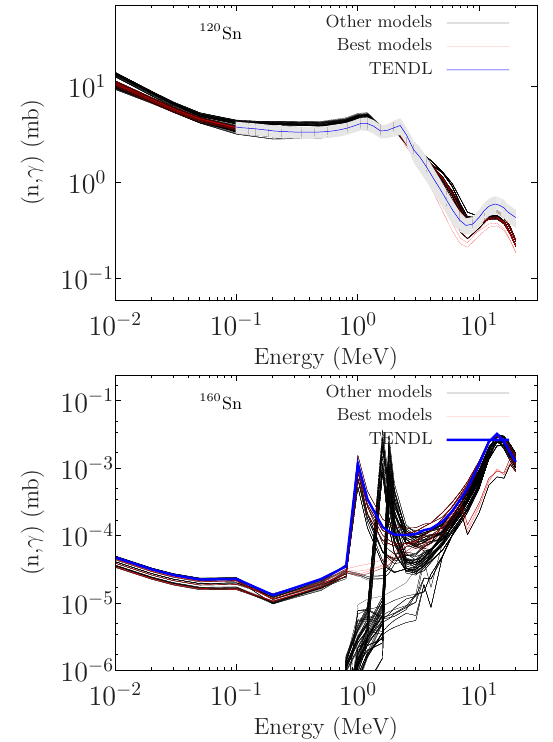
Figure 1: Example of radiative neutron-capture cross sec- tions for two Sn isotopes (from top to bottom: 120 and 160). For each mass, 288 TALYS calculations are pre- sented, based on di ff erent model